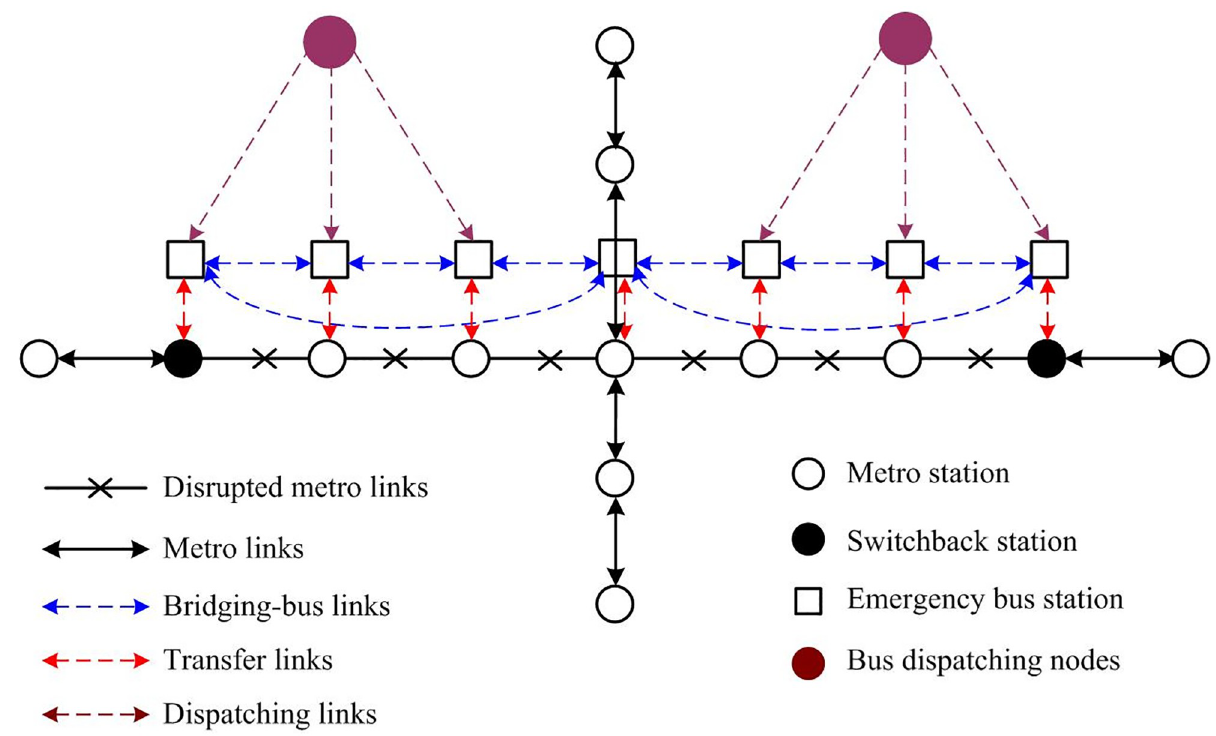
Fig 2. Representation of the integrated metro and bus